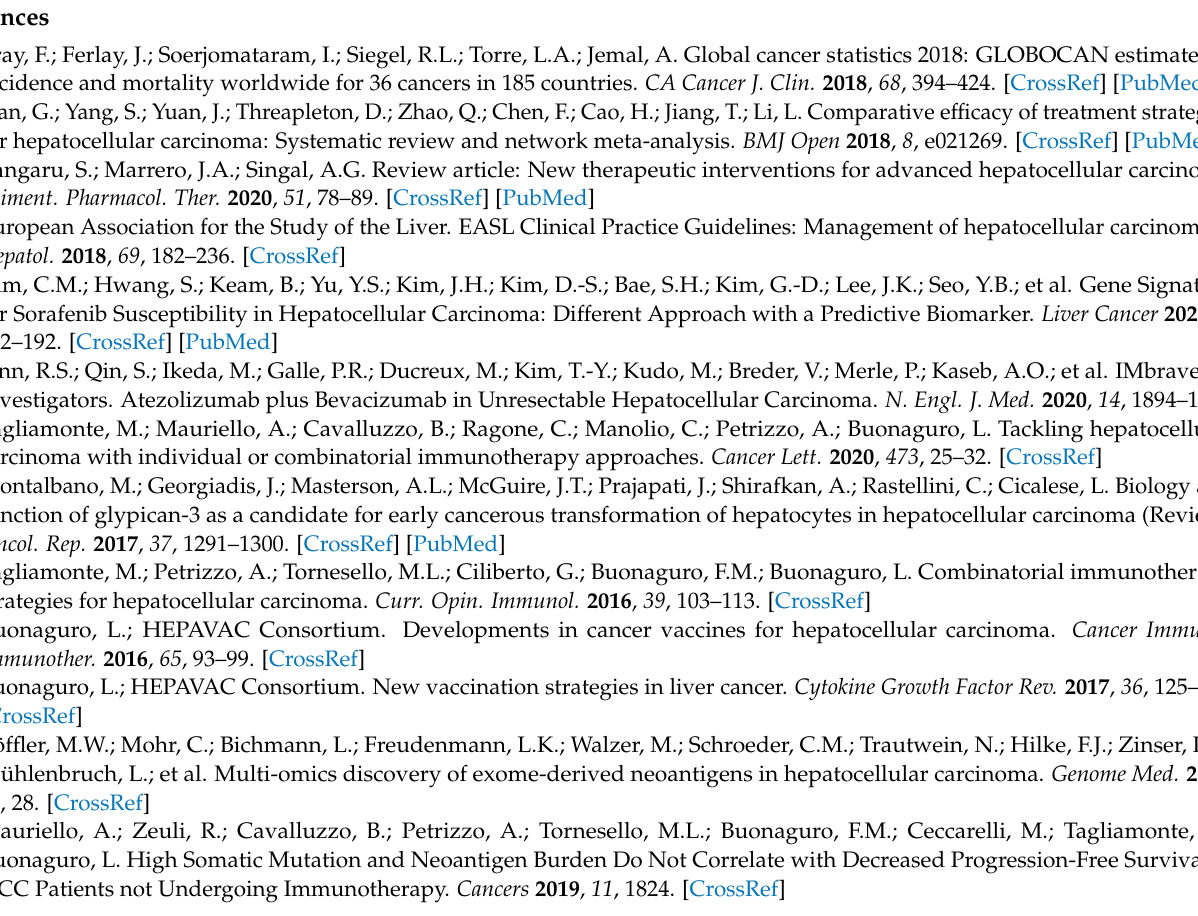
Figure S13: Predicted 3D conformation of paired peptides. The conformation of the TAA peptides and paired viral antigens bound to the HLA-A*24:02 molecule, Figure S14: Molecular docking of DYRK4-TAA and influenza virus paired HLA-A*24:02 epitopes. Outlined areas show the aminoacidic substitutions that modify the 3D structure of the peptide in the portion facing the TCR molecule. Figure S15: Evaluation of epitope-specific CD8 + T-cell clones recognizing TAA epitope, VIRAL paired epitope, and both peptides (CROSS). Data from HCC and healthy donors are shown, Figure S16: Pipeline applied in the study. Strategy for selection of HCC-specific proteins, epitope prediction, and